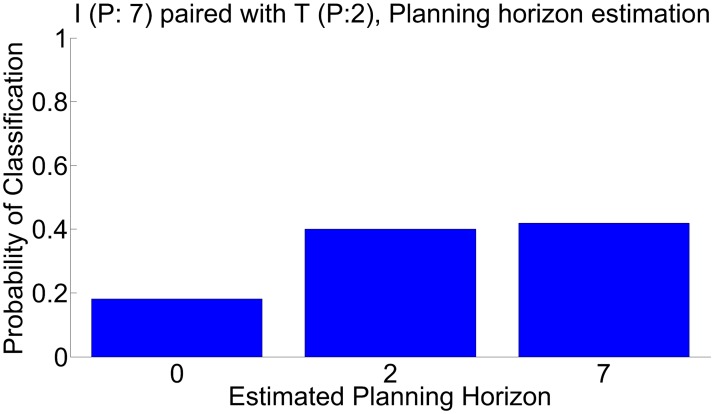
Planning misclassification.Maximum likelihood estimation result, P
I = 7 and P
T = 2 agent combinations, marginalized maximum likelihood estimation of investor planning horizon over all other parameters.